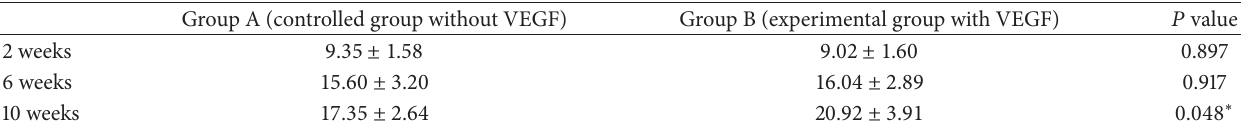
Table 1: Quantification of MVD (X ± SD, vessels/HPE) between group A and group B, analyzed by histomorphometrics. 𝑃 values < 0.05 were marked ( ∗ ).